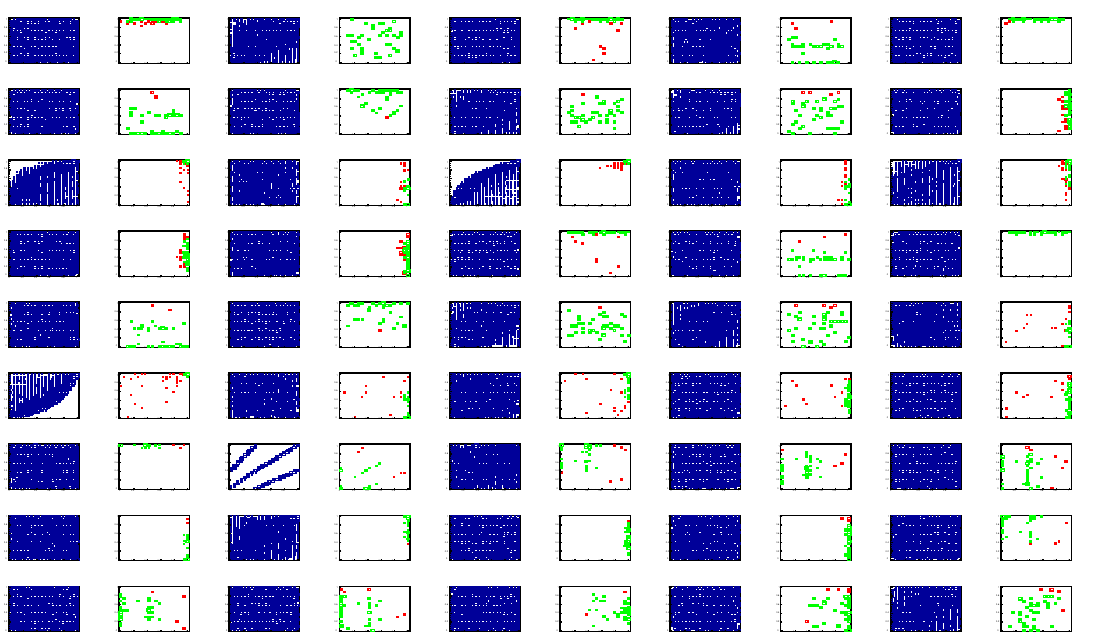
Figure 14 . Two-feature copula-space distributions from test 9 in table 5. Each left graph in a pair (columns 1,3,5,7,9) shows the totality of the data (blue scatterplots with 5000 events, including a 3% signal component) on the 45 combinations of the 10 features (out of D 0 highest- R box; the corresponding graph on the right shows the data selected in the best box (in 1 green), and data failing the selection only because of the values of the features shown in the graph (in red). From left to right, the shown pairs of features are: [1,6], [1,11], [1,14], [1,9], [1,10] (row